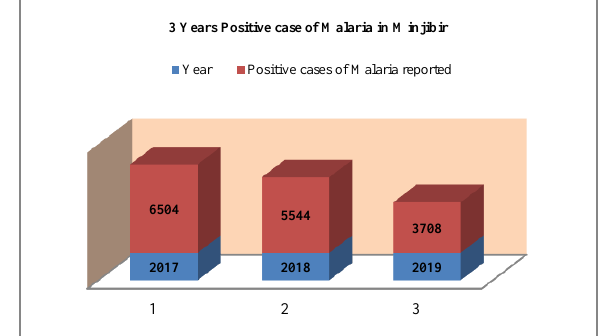
Figure 8: 3 years positive cases of Malaria in Minjibir